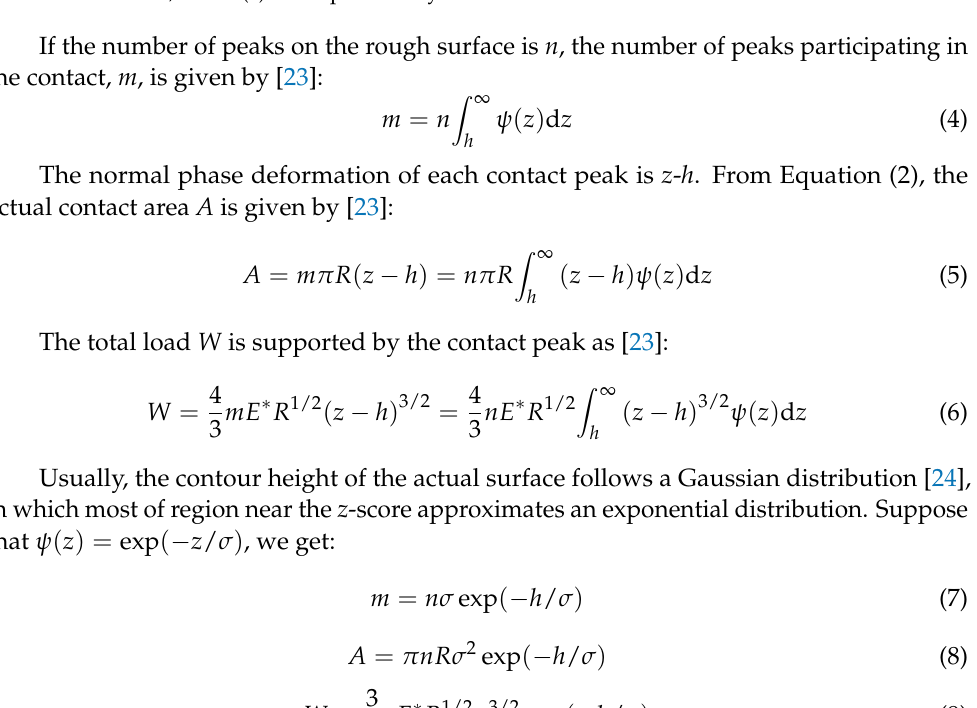
Figure 3. Contact of rough surfaces. The root mean square values of the roughness of the two surfaces are respectively σ 1 and σ 2 , h is the distance between the center lines, z is the part of the contour height z > h contacts with, and Ψ ( z ) is the probability of the surface contact.